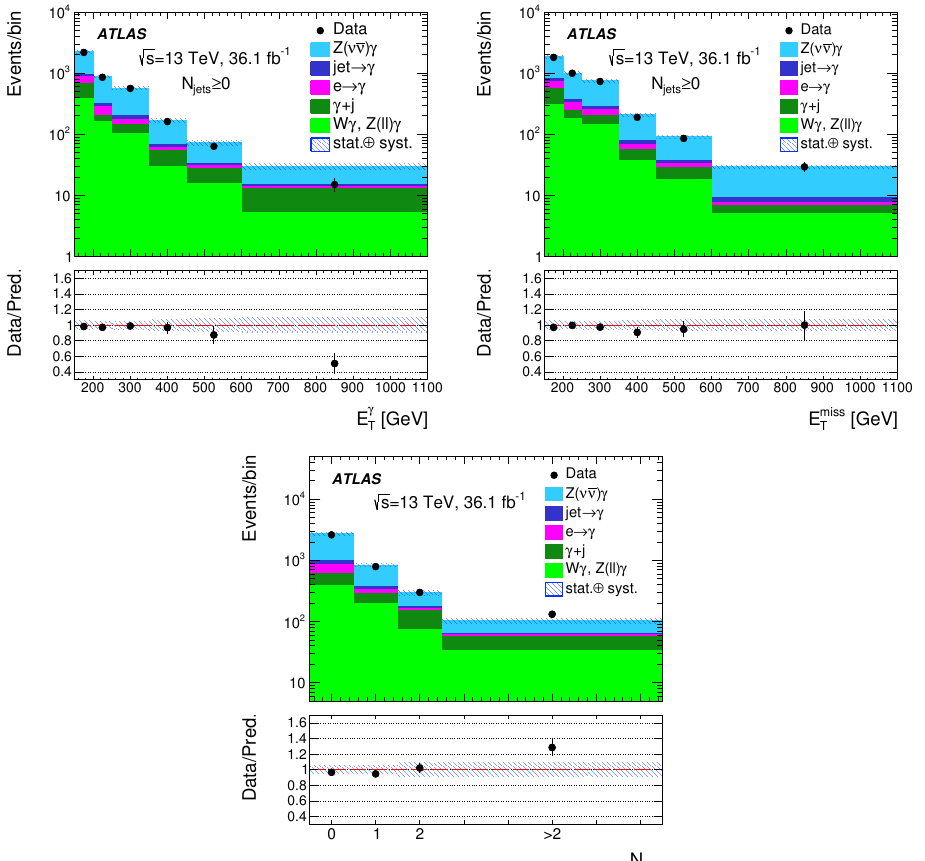
Figure 2 . Top left: photon E T distribution; top right: missing transverse momentum distribution; bottom: jet multiplicity distribution, in the inclusive ( N jets 0) signal region. MC expectations are (cid:21) scaled to the integrated luminosity of the data using the expected MC cross section of each sample. The W(cid:13) and (cid:13) +jet backgrounds are scaled by an additional normalization factor from the (cid:12)t to data in the corresponding control regions. Backgrounds arising from electron or jet misidenti(cid:12)cation as a photon are estimated with the data-driven techniques described in the text. The dashed band represents the sum in quadrature of systematic and statistical uncertainties of both the background and signal expectation, and includes a contribution arising from the uncertainty in the integrated luminosity of the data